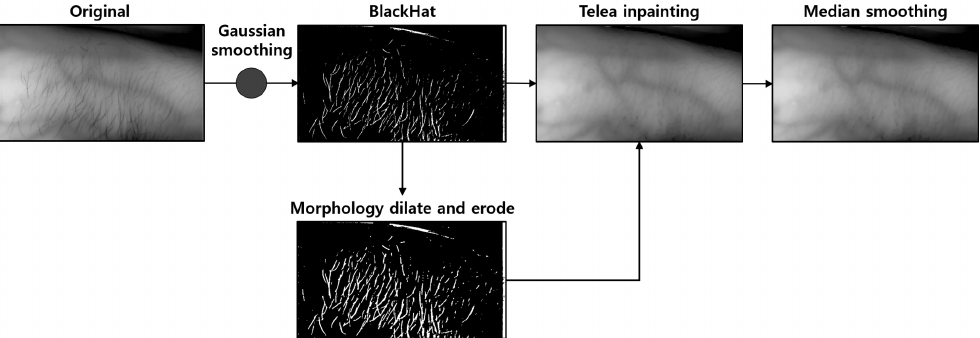
Figure 11. Hair removal algorithm